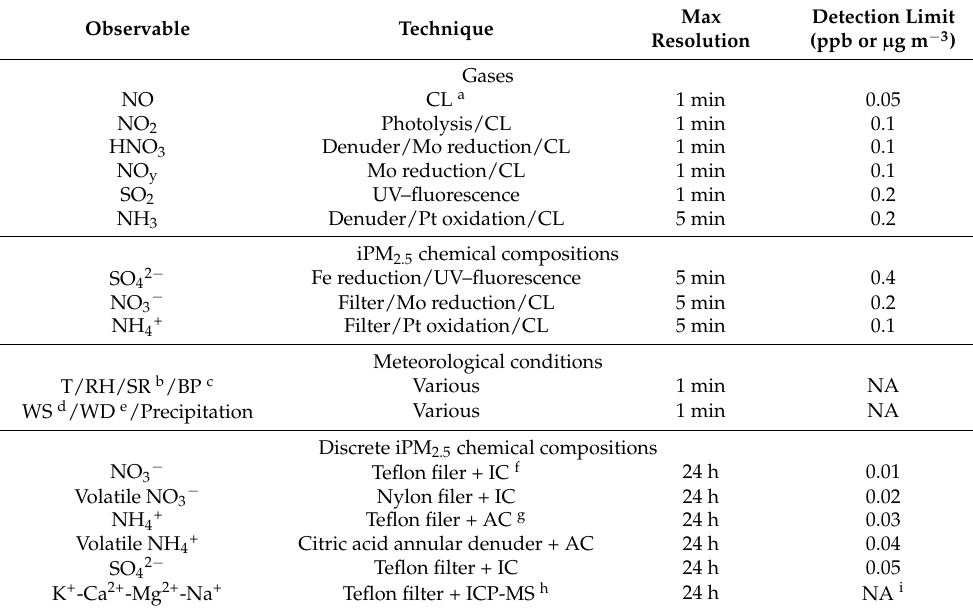
Table 1. Continuous and discrete field measurements at the eight